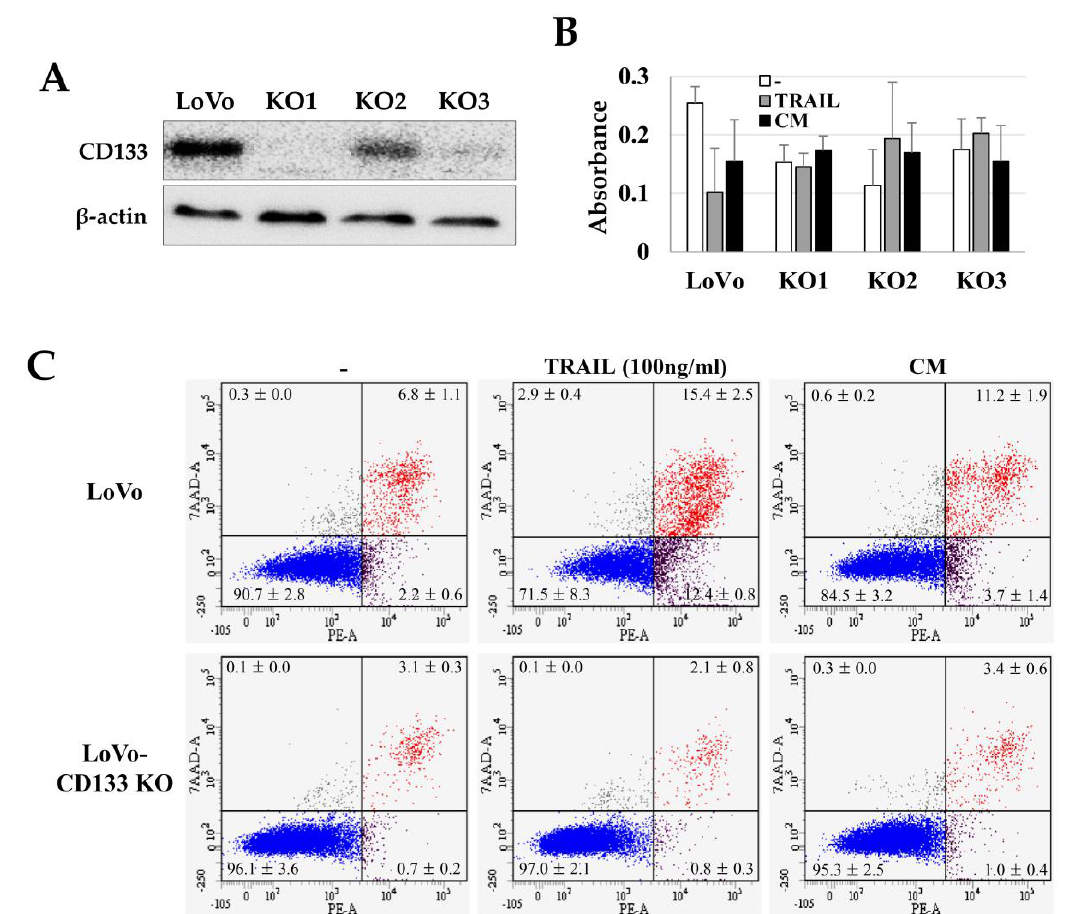
Figure 3. TRAIL sensitivity in LoVo and CD133 knockout LoVo cells (LoVo-CD133 KO cells). Three independent LoVo-CD133 KO cells (KO1, KO2, KO3) were generated using the CRISPR-Cas9 gene editing system and culturing a single colony. ( A ) Immunoblotting of CD133 expression in LoVo-CD133 KO cells. ( B ) Toxicity of TRAIL in LoVo-CD133 KO cells. TRAIL reduced the viability of LoVo cells, but TRAIL-dependent toxicity was not observed in all the KO cells. Data are presented as the mean ± SE of three independent experiments. ( C ) Sensitivity to TRAIL by LoVo and LoVo-CD133 KO1 cells. TRAIL-induced apoptosis was analyzed by Annexin-V/7-AAD staining and flow